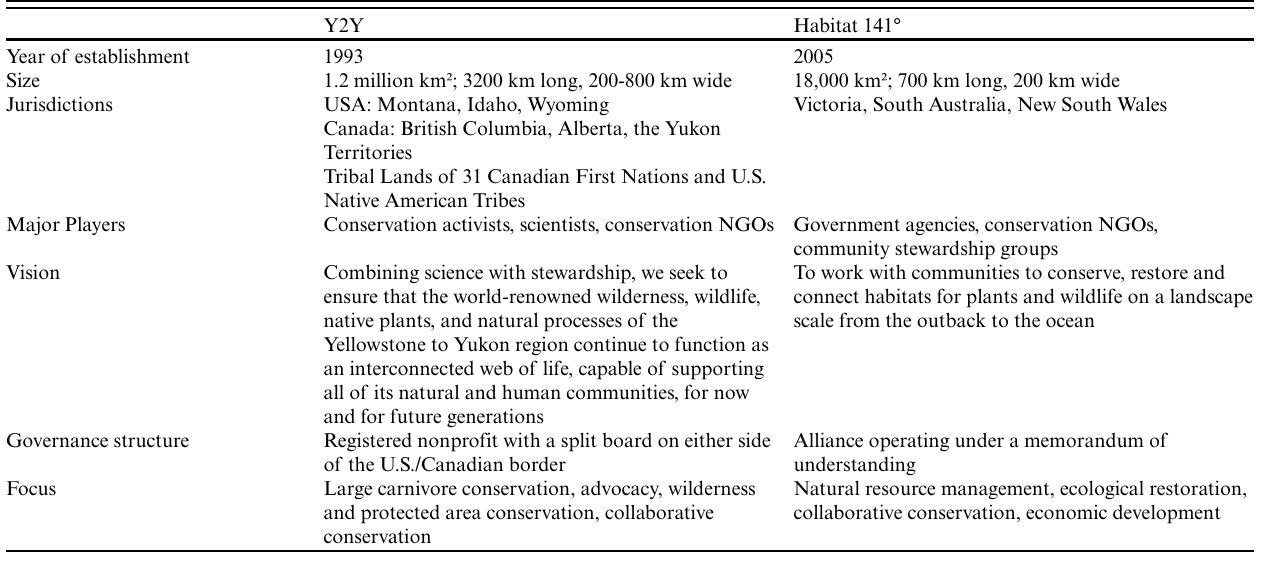
Table 1 . Basic comparison of Y2Y and Habitat 141°.